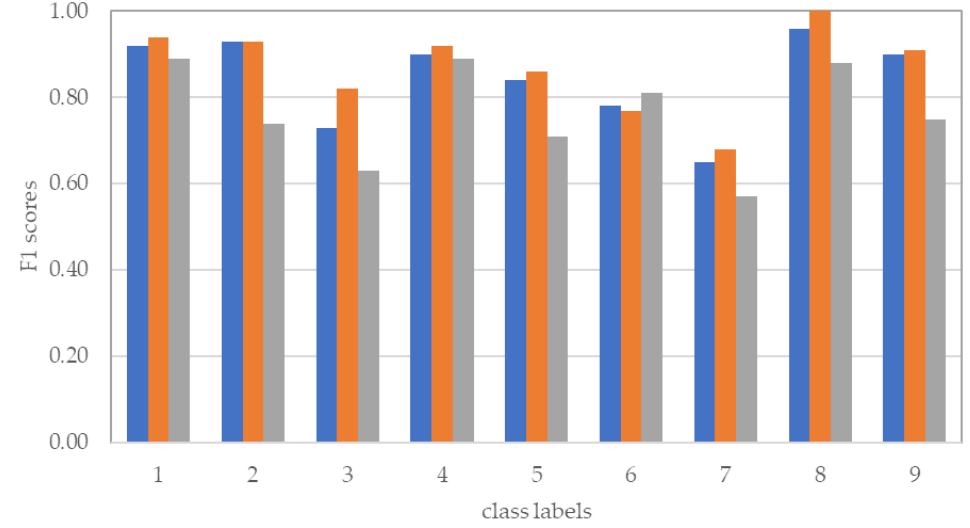
Figure 7. Classification performance of models trained on bronze standard sets generated automatically with TopicDiff-LDA (blue and orange bars for training on review- and segment-level, respectively) and MLTM (gray bars).